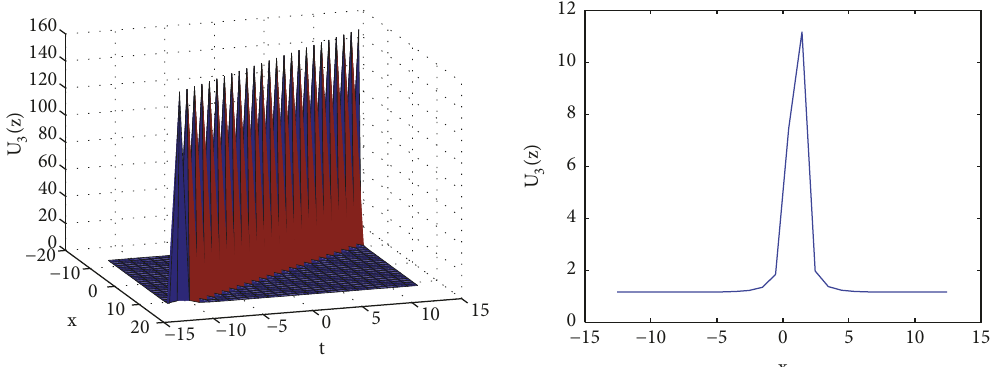
Figure 7: The 3D and 2D surfaces of 𝑈 3 (𝑧) by considering the values 𝑘 = 1 , 𝐿 = 1 , 𝜆 = 1 , 𝛼 = 1 , 𝑦 = 0 , 𝑧 0 = 1 , and 𝑡 = 0 for the 2D graphic.